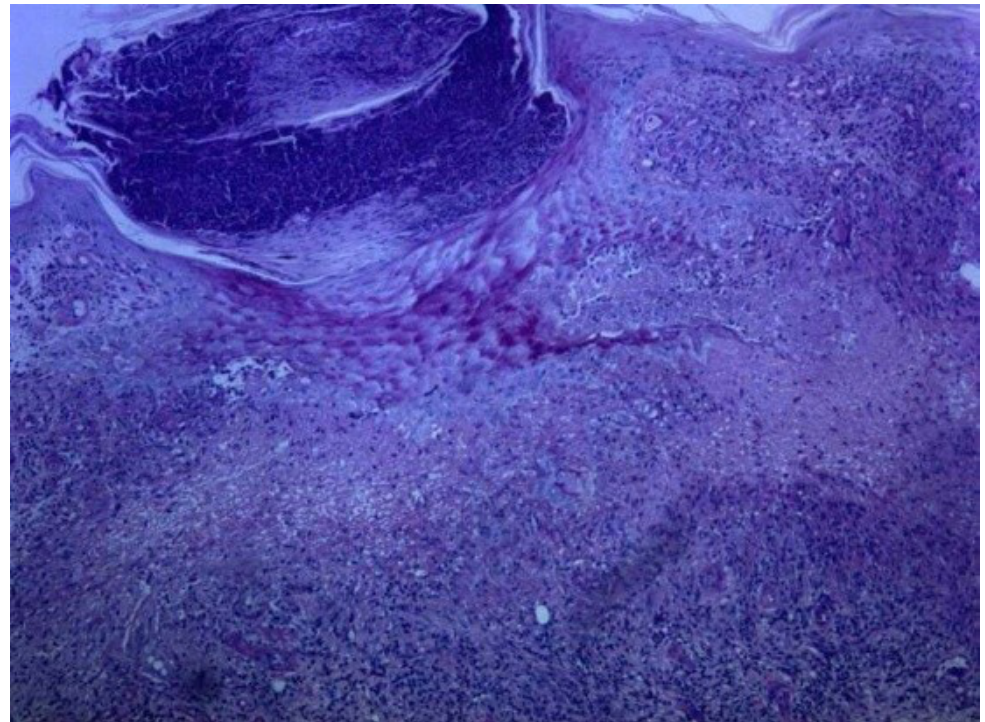
Figure 3. Collagen degeneration and transepidermal elimination (H&E ×